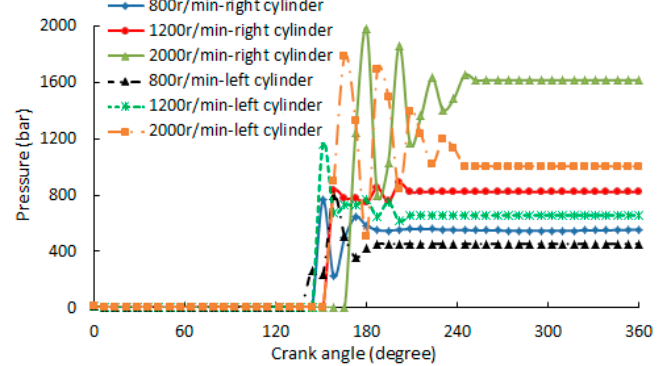
Figure 8. Pressure of the left cylinder at different engine speeds with the same adjustment quantity.